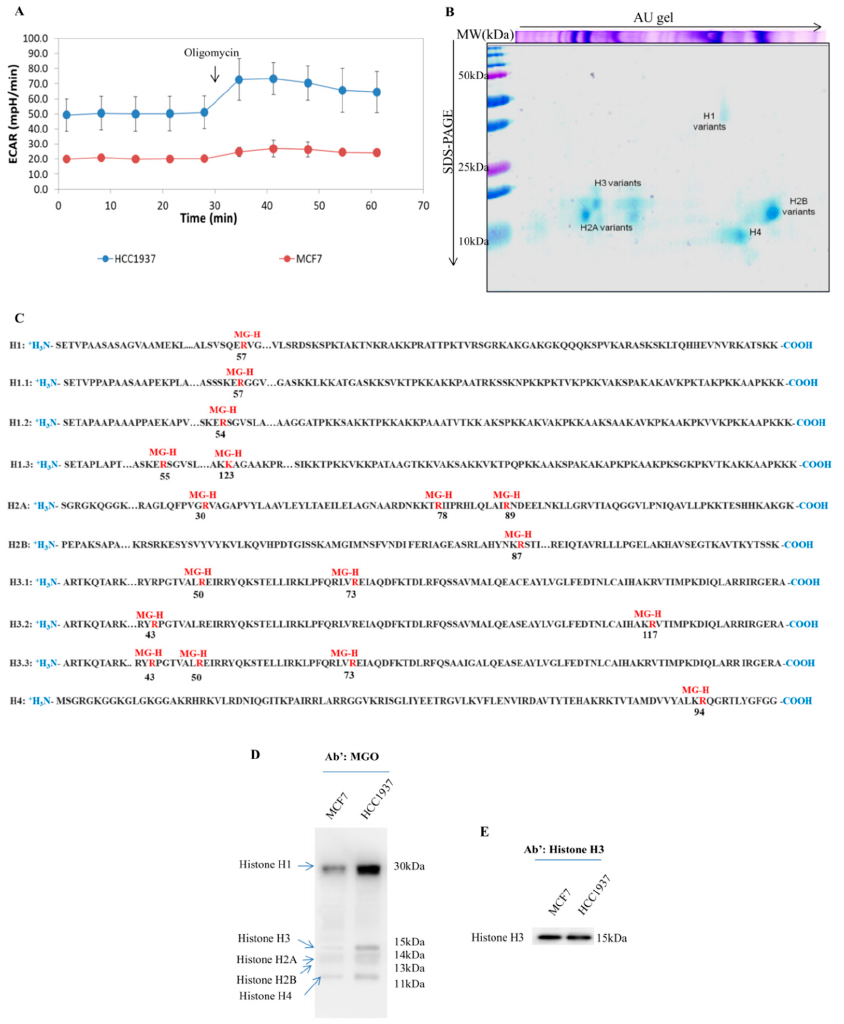
Figure 1. Advanced glycation end-products (AGEs) detection on histone from breast cancer cells; ( A ) Glycolytic activity was measured by the extracellular acidification rate (ECAR). The study was done using the XFp Analyzer. The analysis reveals increased glycolytic activity in HCC1937 breast cancer cells as compared to MCF7 breast cancer cells. The complete report analysis was provided as Supplementary File S1; ( B ) Histones proteins were extracted in acidic conditions and analyzed using Triton-Acid-Urea (TAU) gel. The method resolves very basic proteins combining two perpendicular separation methods. In the first-dimension histones migrate in function of their isoelectric point an hydrophobic properties, in the second dimension histones are resolved based on molecular weight. Histone spots were excised, trypsin digested and identified by LC-MS / MS analysis. Mass spectrometry analysis was done focusing on methylglyoxal (MGO) as post-translational modifications (PTM); ( C ) Mass spectrometry analysis of MGO on histones sequences. In the Figure, the main glycated residue on histone sequences is reported. Each identified glycated residue is bold red. MG-H is acronym of methylglyoxal-derived hydroimidazolone. The number under the red residue indicates the position of the amino acid. LC-MS / MS identification data and MS / MS spectra were provided as Supplementary Files S2 and S3; ( D ) Western blot analysis of MGO-modified histones. Histones proteins were resolved on 15% SDS-PAGE and transferred to a nitrocellulose membrane using the Trans-blot turbo system (Bio-Rad). Membranes were hybridized with primary antibodies against MGO-adducts. Western blot patterns were analyzed using Image Master 2D Platinum software. The analysis allows us to conclude that MGO adducts were more abundant in HCC1937 cells compared to MCF7 breast cancer cells; ( E ) MGO Western blot signal was normalized against the whole levels of Histone